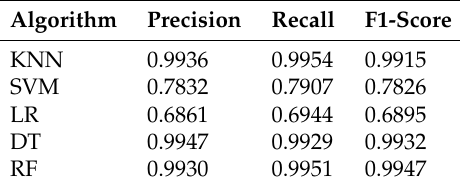
Table 7. Unbalanced ISCX-Bot-2014 scores.